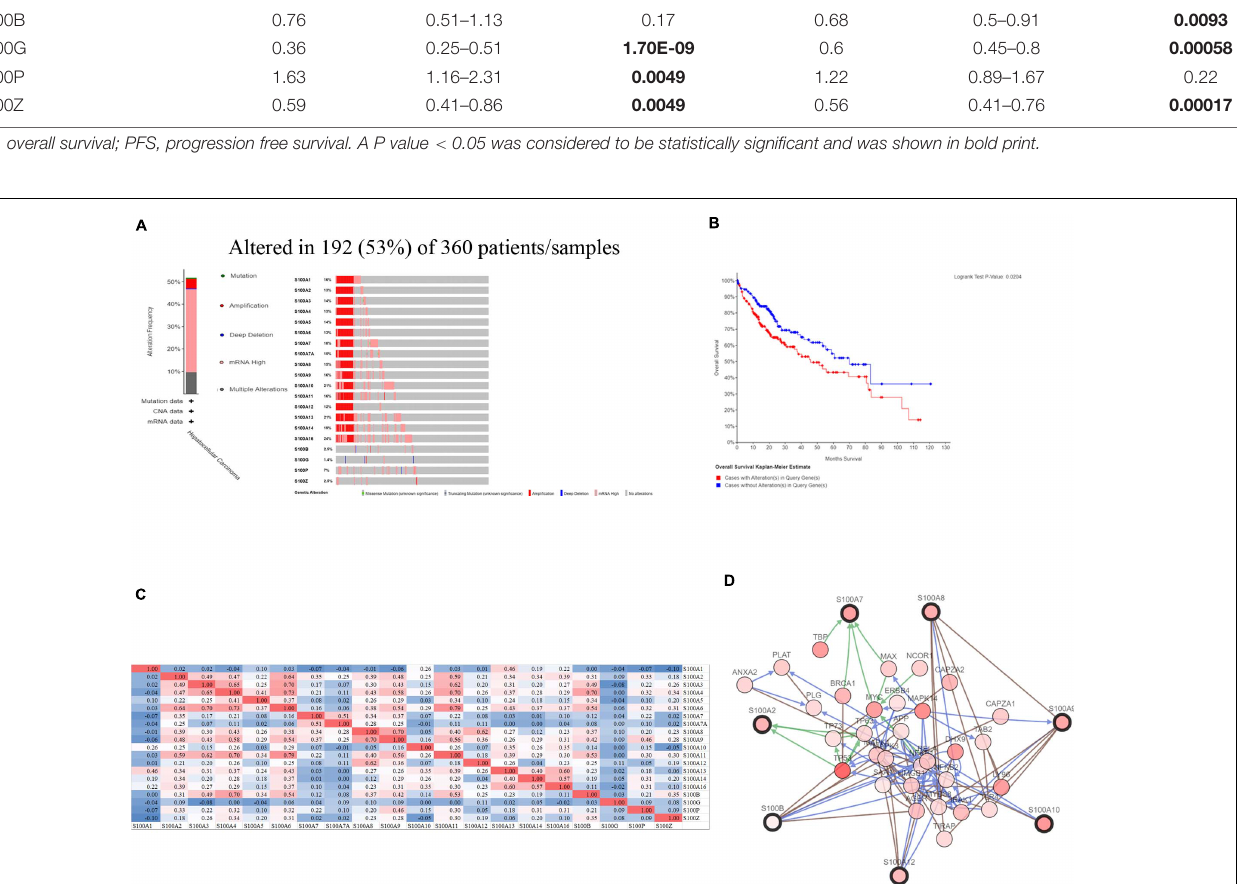
Frontiers in Genetics |